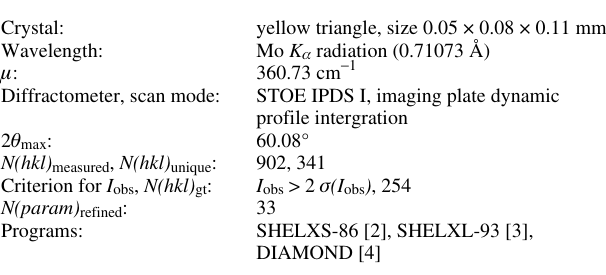
Table 1. Data collection and